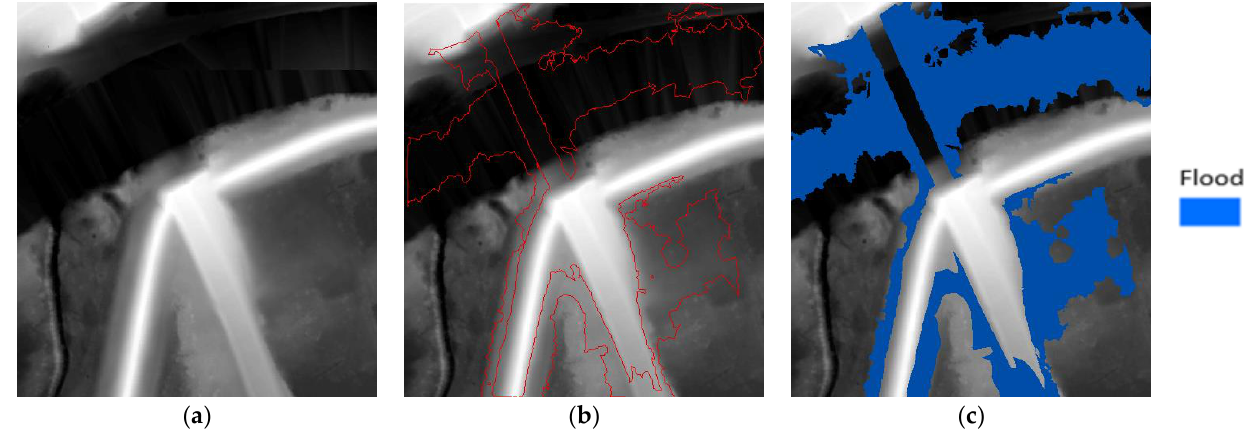
Figure 6. Three-dimensional surface reconstruction using DEM and CNN; ( a ) pre-flood DEM; ( b ) intersecting flood extent polygons (red polygons) and DEM and extract Z value for each polygon; ( c ) 3D water surface (raster format).